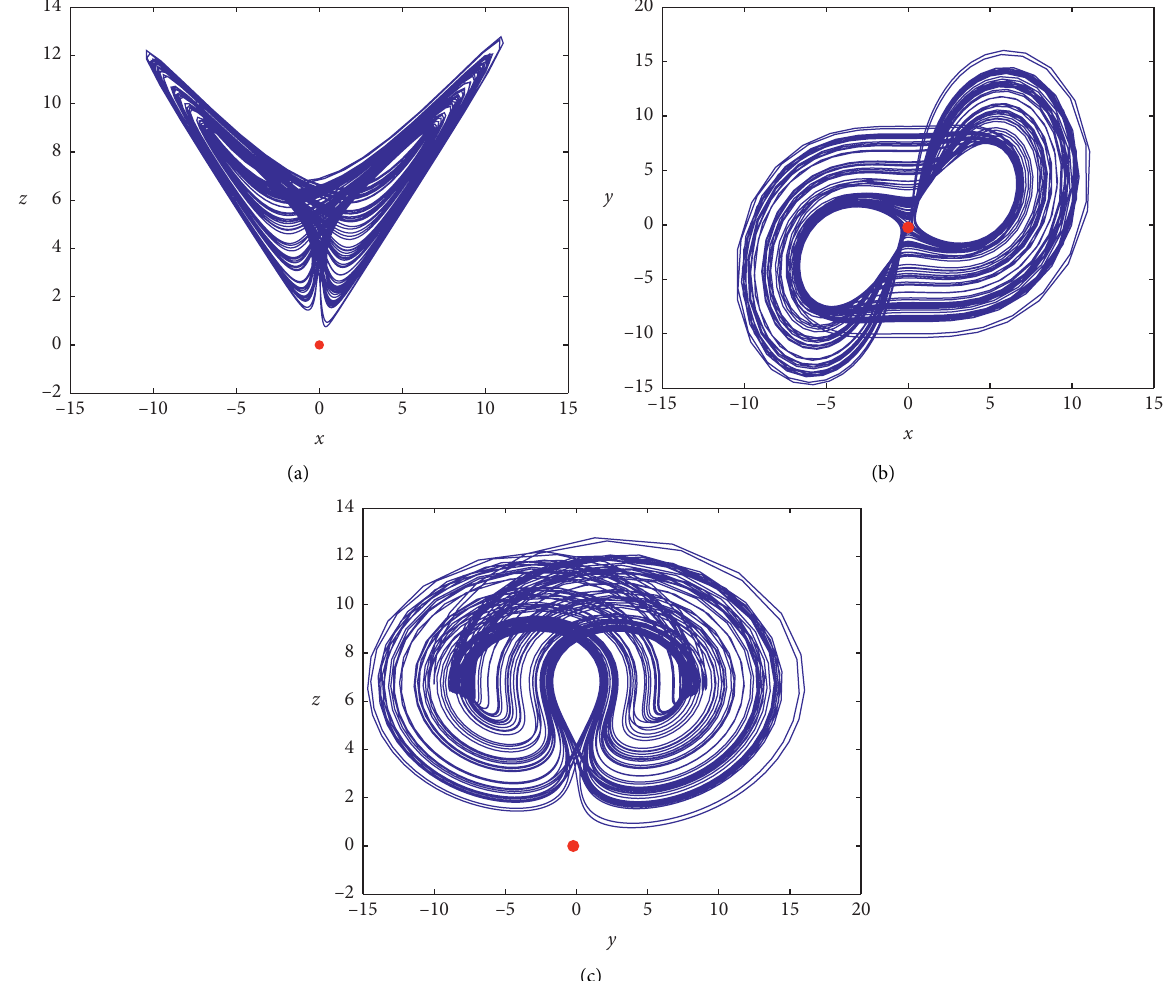
Figure 4: Phase diagrams in different projections of fractional-order chaotic systems from initial values (1, 2, 3), red, and (1, 2, − 1). (a) Phase portraits in the ( x )-( z ) plane. (b) Phase portraits in the ( x )-( y ) plane. (c) Phase portraits in the ( y )-( z )